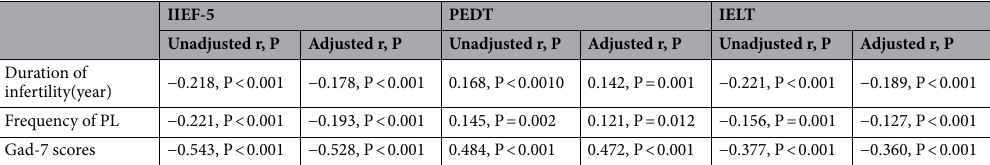
Table 3 sought to evaluate associations between SDs and duration of infertility, frequency of PL, or anxiety. PEDT scores were positively associated with the duration of infertility (adjusted r = 0.168; P = 0.001), frequency of PL (adjusted r = 0.154; P = 0.012), and GAD-7 score (adjusted r = 0.472; P < 0.001). The IIEF-5score and IELT was negatively associated with the duration of infertility, frequency of PL, and GAD-7 score, all after adjusting for age. Figure 1 detail the ORs of ED occurrence through the duration of infertility and the frequency of PL, the PC group was used as baseline. The incidence of ED increases gradually with the duration of infertility and the frequency of PL, the highest ORs appeared in ≥ 5 years of infertility(adjusted OR = 7.346, 95% CI:4.329–12.467; P < 0.001) and frequency of PL ≥ 3(adjusted OR = 6.282, 95% CI:3.446–11.453; P < 0.001).